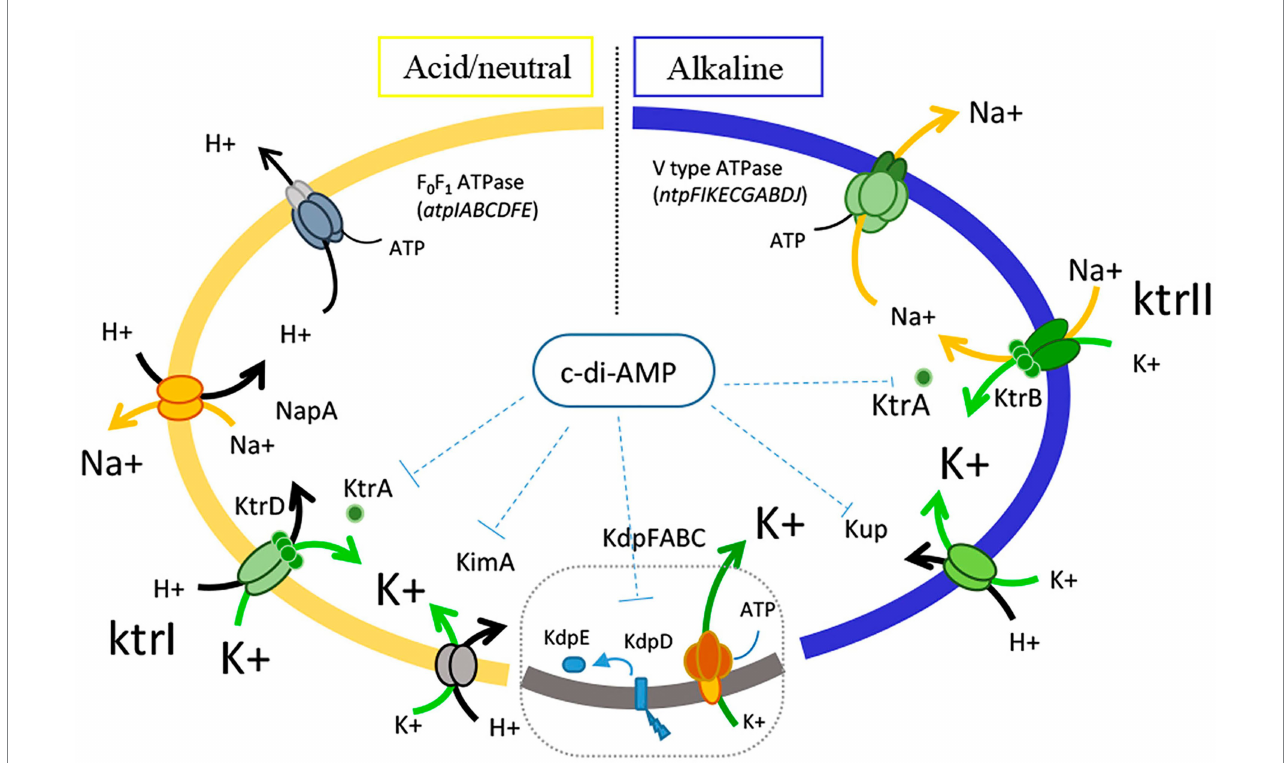
FIGURE 1 Schematic representation of the mechanisms involved ion fluxes in Enterococcus faecalis